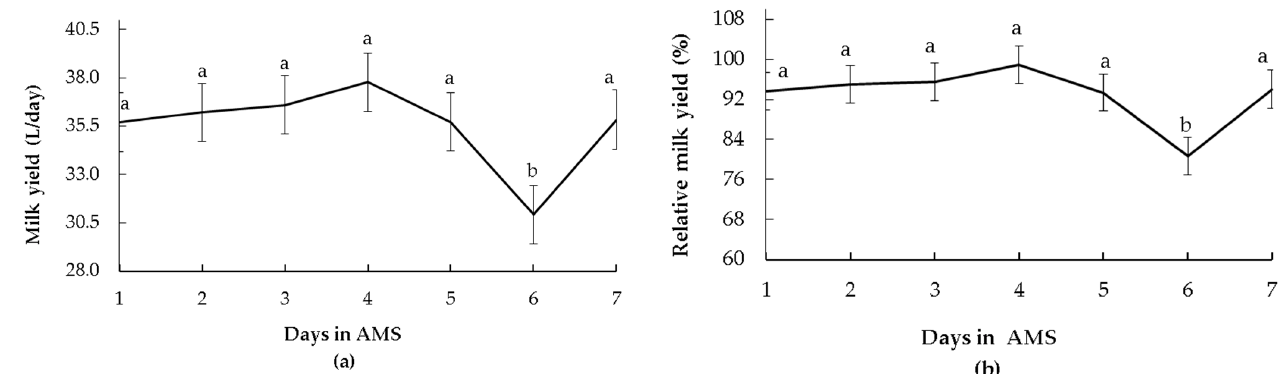
Figure 3. ( a ) Total milk yield (mean ± SE) and ( b ) milk yield (mean ± SE) expressed as relative values of conventional milking system (CMS) results (100% = mean CMS yields of seven days prior to the system changeover) of multiparous Holstein cows during seven days after the changeover from the CMS to the automatic milking system (AMS). Differences between days are indicated with different letters ( p ≤ 0.05).